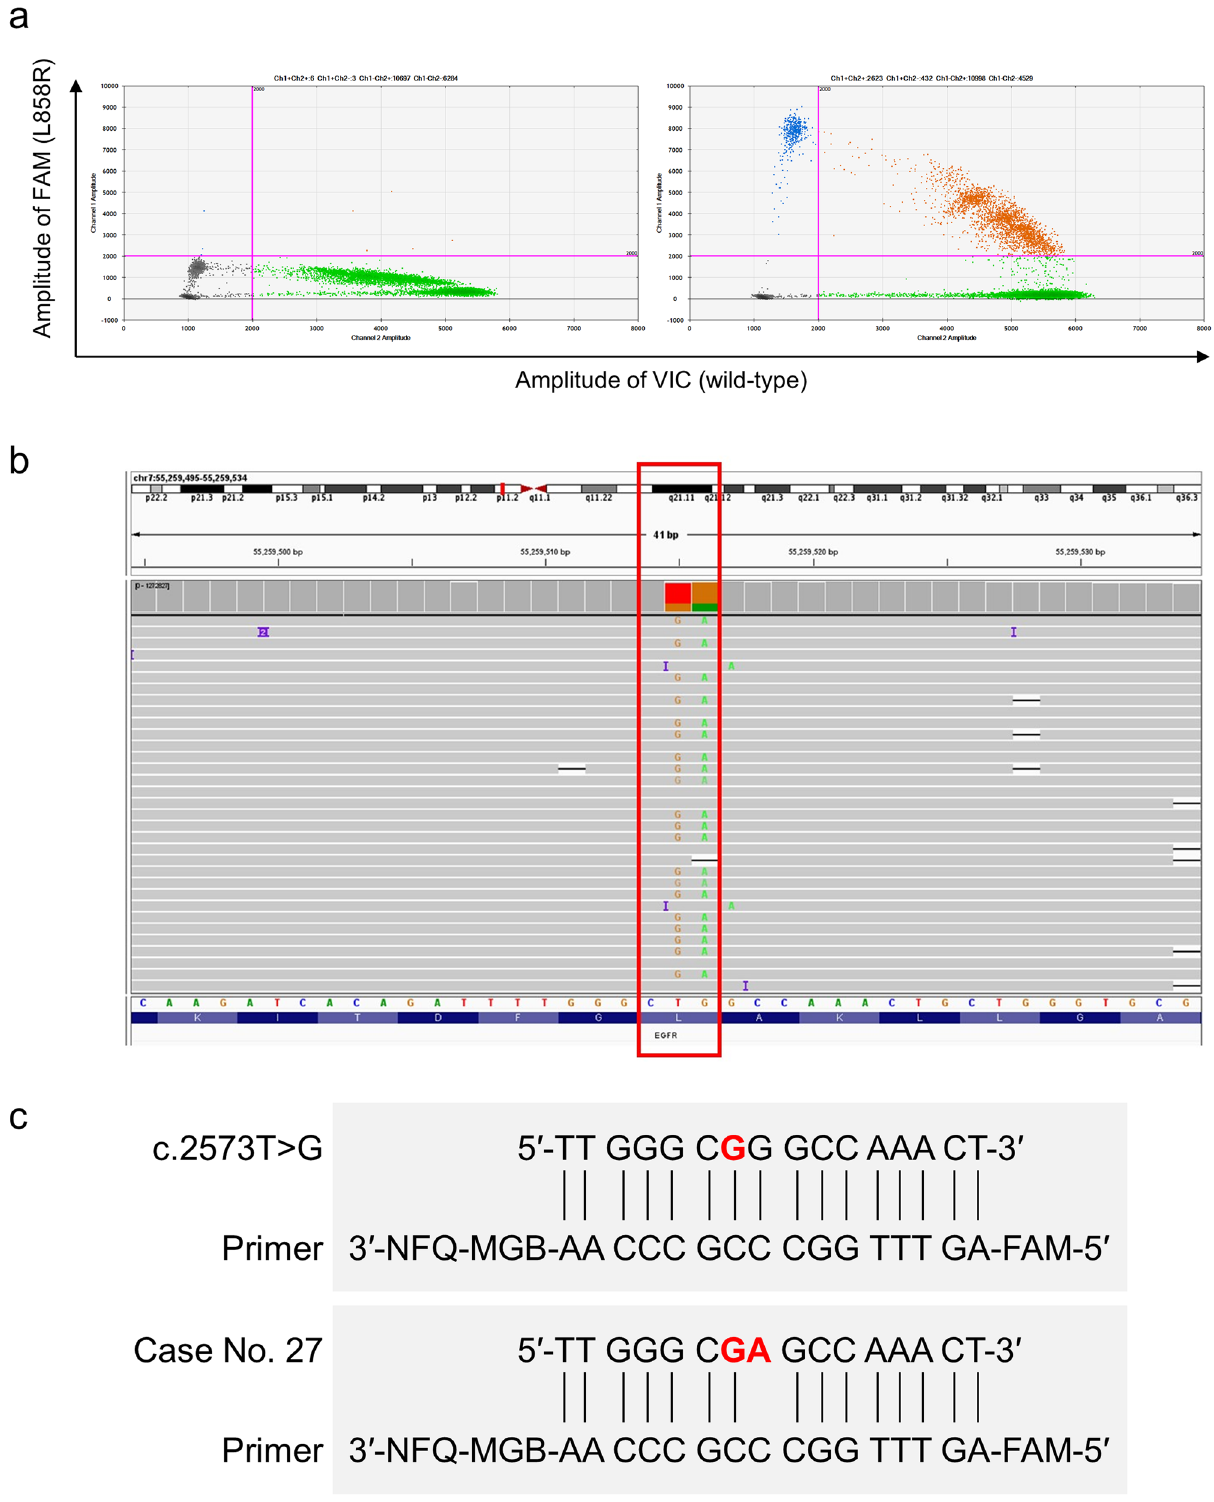
Figure 3. Two-base substitution-induced EGFR L858R mutation in patient no. 27. ( a ) The droplet digital polymerase chain reaction (ddPCR) result showing only a few FAM signals above the threshold indicative of a remarkably low level of the L858R circulating tumor DNA allele fraction (left). The right panel in patient No. 28 represents a typical result of ddPCR showing distinct signal clusters of L858R (c.2573T > G). ( b ) The sequence read by nonoverlapping integrated read sequencing system showing the L858R mutation due to a two-base substitution (within the red square). ( c ) Primer-DNA hybridization of the targeting sequence used in this study in typical L858R-mutant cases (c.2573T > G [red]; top). A mismatch caused by the two-base substitution (c.2573_2574delinsGA [red]) is shown